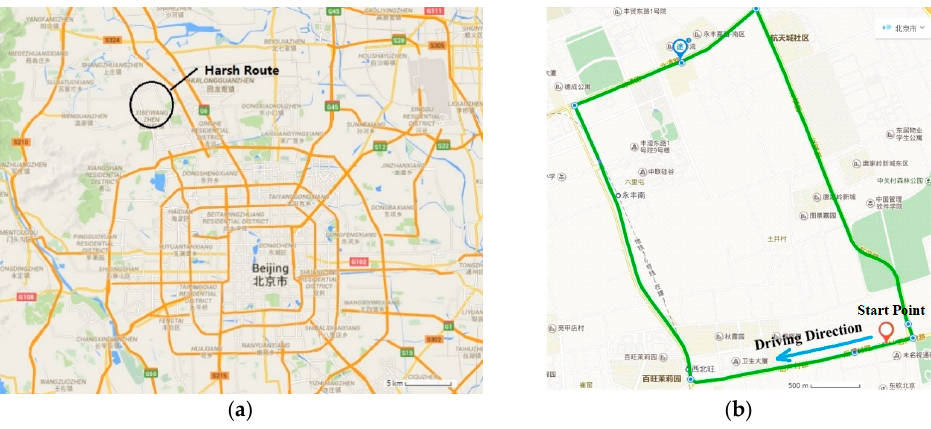
Figure 12. Map of harsh route ( a ) Schematic map; ( b ) Detail map.